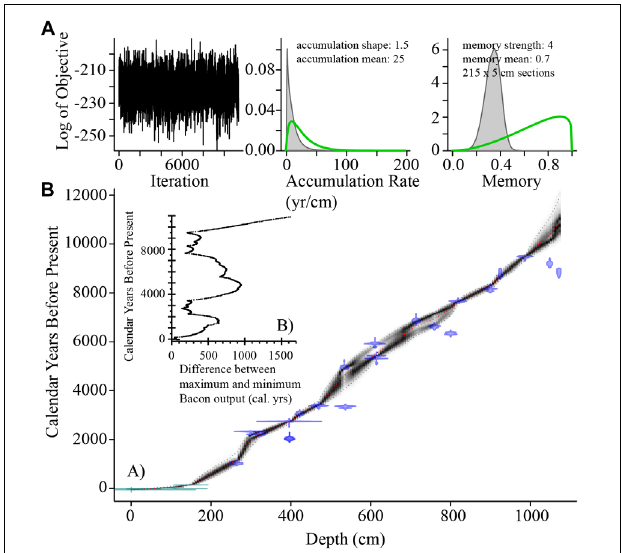
FIGURE 2 | (A) Bacon v.2.2 age model for combined LEGC03-3 and LESS02-11 ages. (B) Difference between maximum and minimum Bacon v.2.2 age model output. Maximum and minimum based on 2.5 and 97.5% quantiles (95% confidence